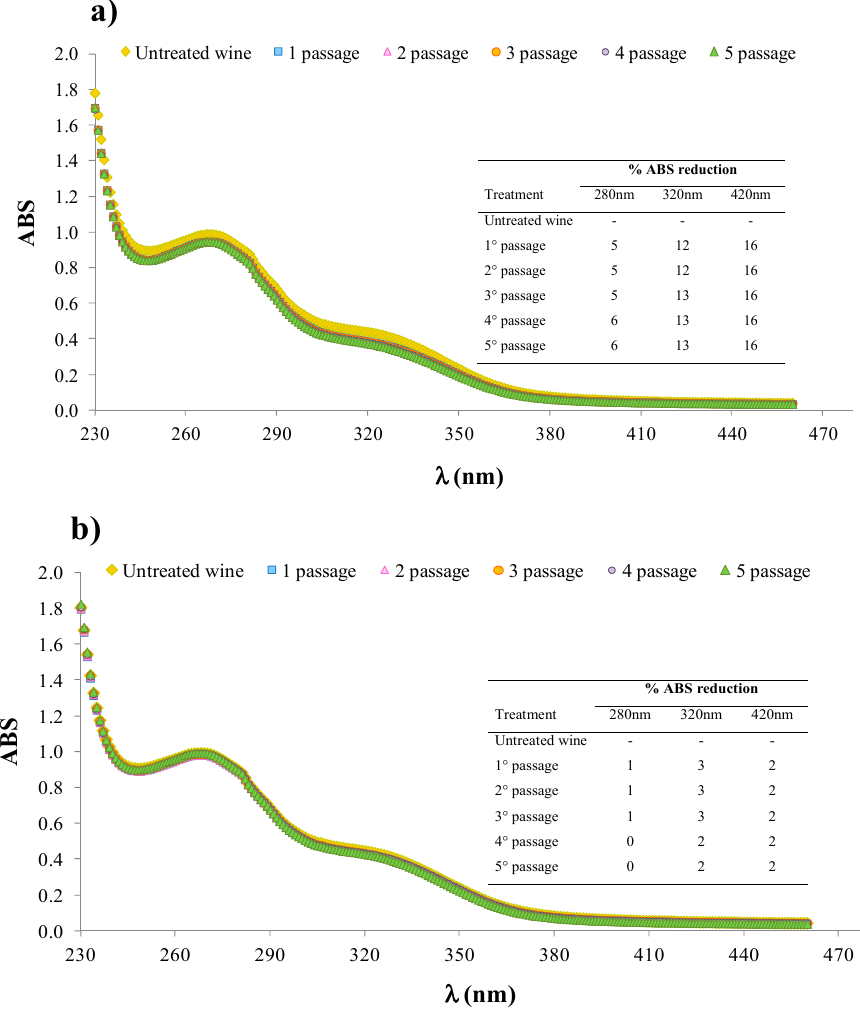
Figure 2. Ultraviolet (UV)-Visible spectra of Sauvignon blanc untreated wine and enzymatically treated in packed bed reactor (five passages) containing bromelain immobilized on Relizyme EP403 / S-GDH ( a ) or on Relizyme EP403 / S-glucosamine ( b ). Table in the insert represent the absorbance reduction (%) of wine samples at three wavelengths (280, 320, and 420 nm).